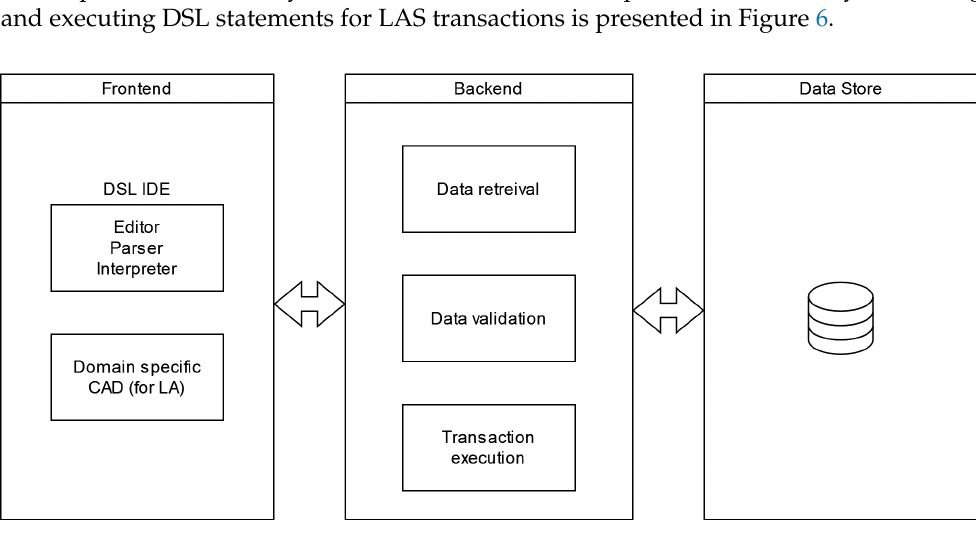
Figure 6. Possible system